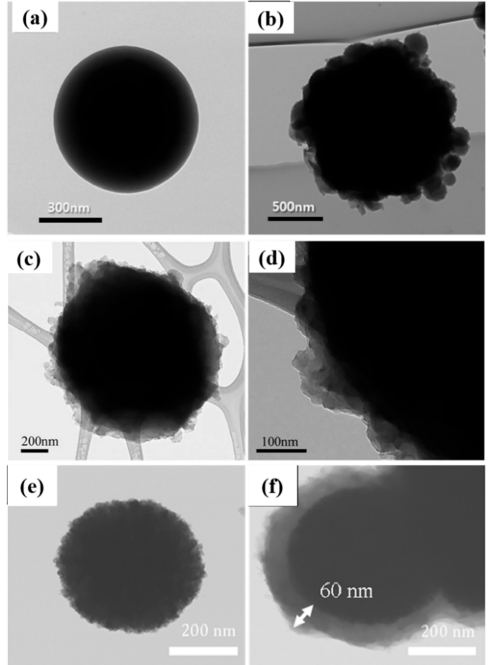
Figure 3. TEM images of PANI derivatives coated nanoparticles: ( a , b ) PMMA and PMMA-PNMA (Moon et al. [77], © Elsevier, 2015); ( c , d ) PEAN-PMMA (Kim et al. [78], © The Royal Society of Chemistry, 2014); ( e , f ) Fe 3 O 4 and Fe 3 O 4 /POA (Lee at el. [81], © by authors, 2019).